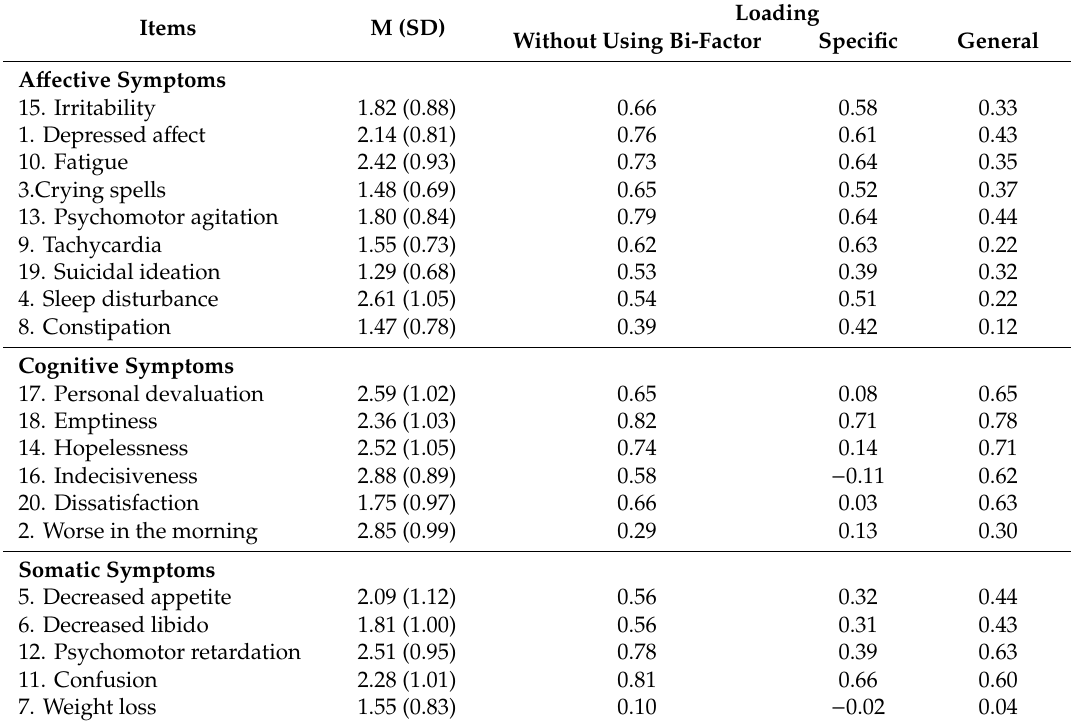
Table 3. Item properties of SDS.